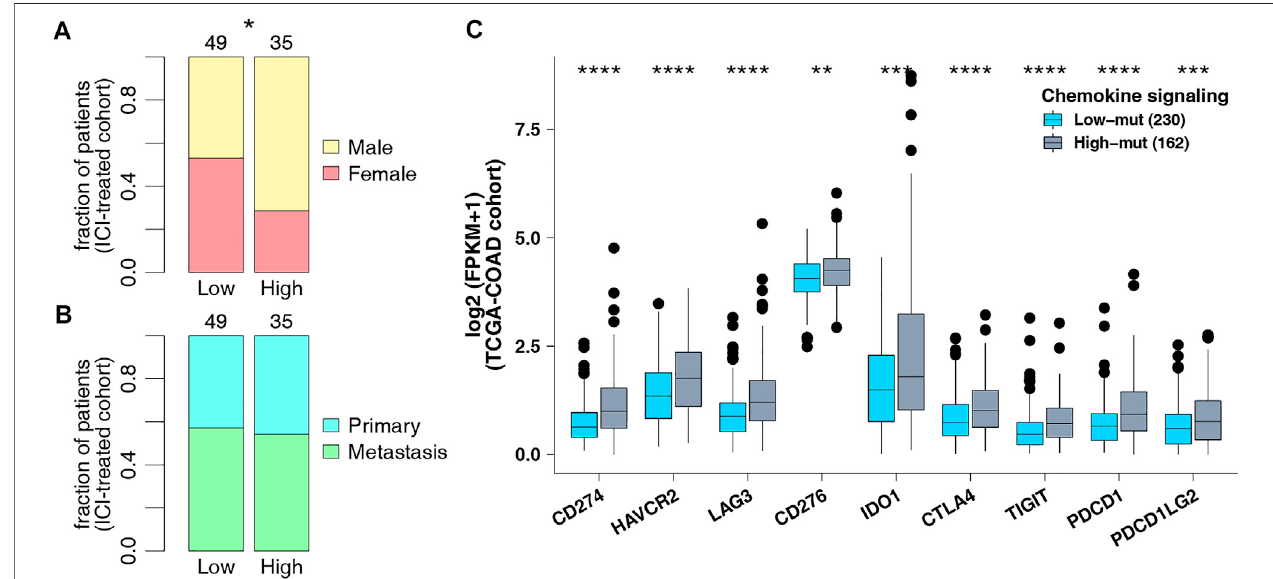
FIGURE3|(A) ComparisonofsexintheICI-treatedcohort. (B) ComparisonofsampletypesintheICI-treatedcohort. (C) Comparisonoftheexpressionofimmune checkpoint genes in the TCGA-COAD cohort.